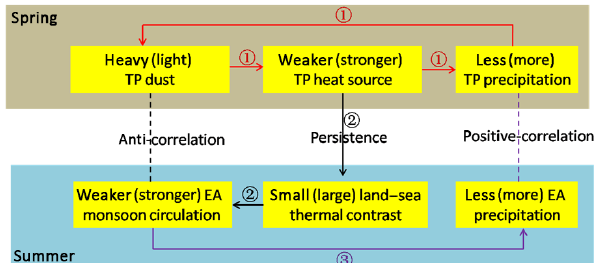
Figure 13. Schematic diagram showing the relationship of dust aerosols emitted from the TP in spring with EASM precipitation. See text for details.